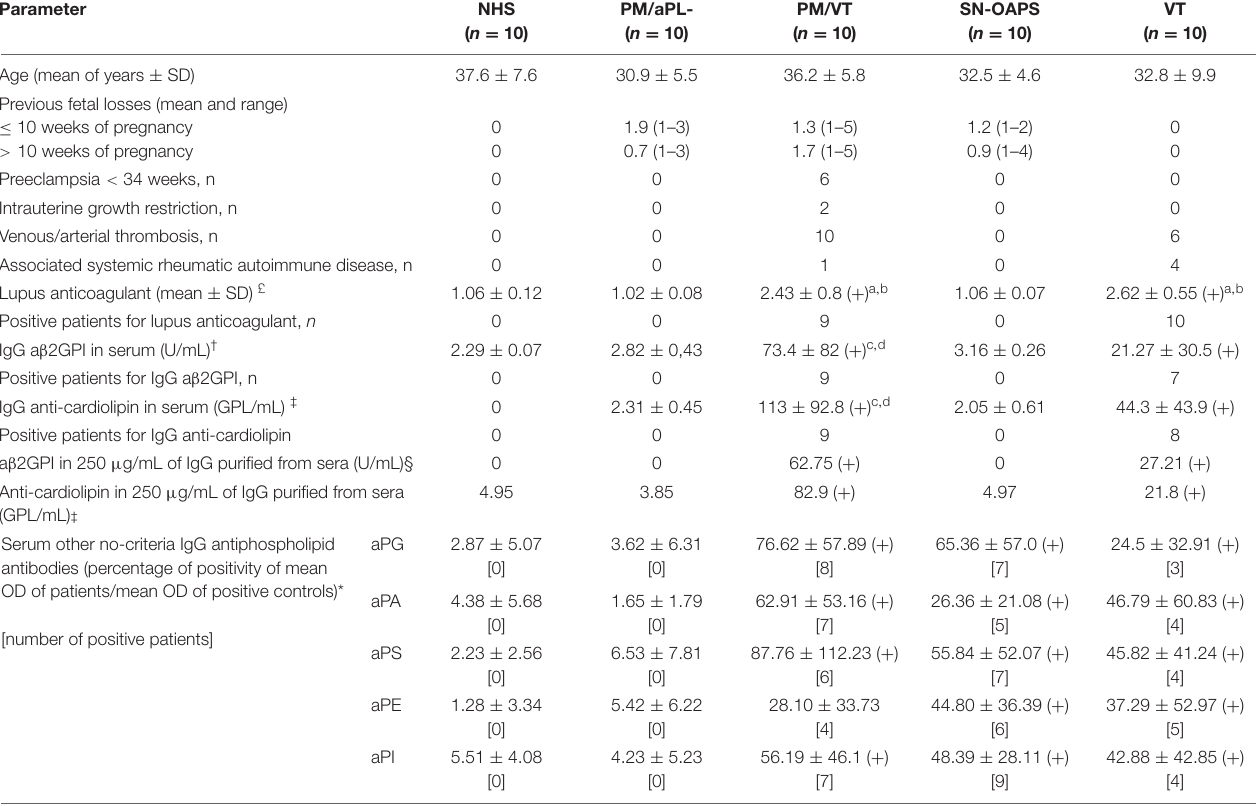
TABLE 1 | Clinical and laboratory features of the women included.